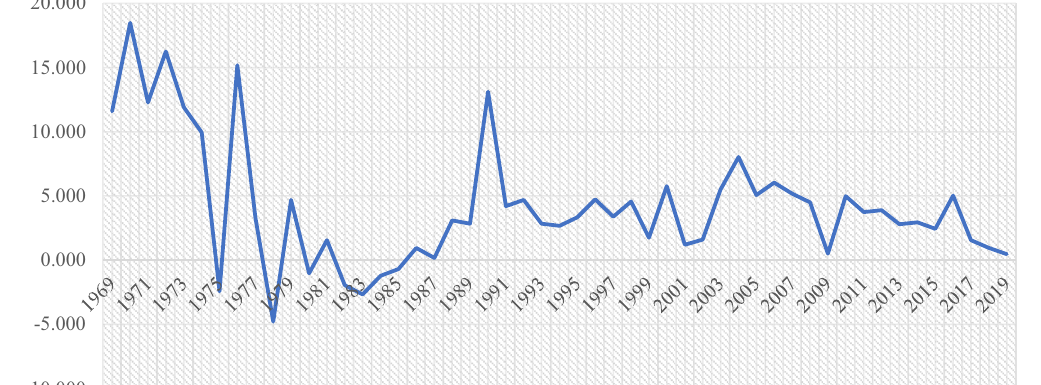
Fig. 15 Trend of GDP growth rate in MENA